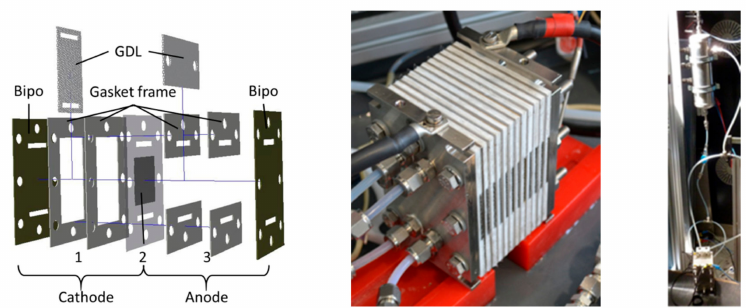
Figure 5. Setup of the cell that was used for the direct coupling of PV and electrolysis ( left ). A stack with the same setup ( middle ); active area: 17.64 cm 2 per cell. The system with the gas separator is shown on the